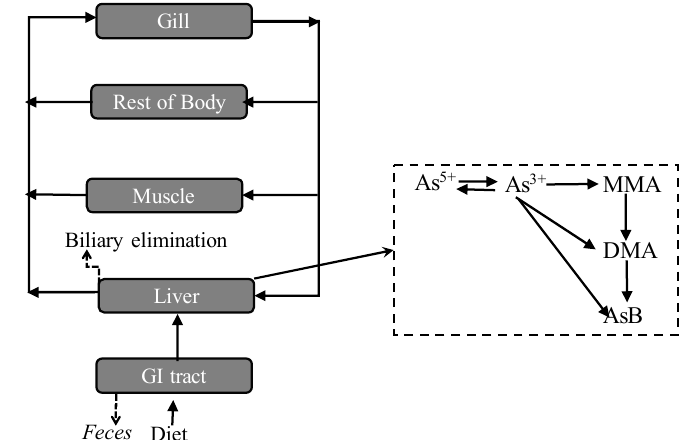
Figure 4. The concentrations of five As species (AsB, DMA, MMA, AS(III) and As(IV)) in: ( a ) intestine; ( b ) liver; ( c ) muscle; and ( d ) gill during 32 days of As(V) exposure. Analysis of variance was used to test differences of arsenic species during experiment period and significance was marked on 32nd day ( p < 0.05).